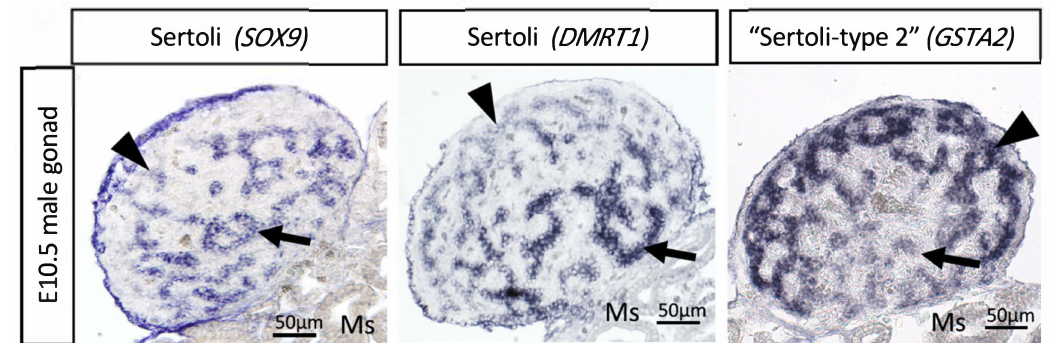
Figure 5. Marker gene expression in E10.5 (stage 35) embryonic chicken testis identifies two Sertoli cell populations. The first is more basally located and highly expresses SOX9 and DMRT1 and lower level GSTA2 (arrows). The second (“type 2” Sertoli cells) is more peripherally located and highly expresses GSTA2 but shows lower levels of DMRT1 and SOX9 expression. (Ms = mesonephric kidney). Reproduced form Estermann et al. (2020) with